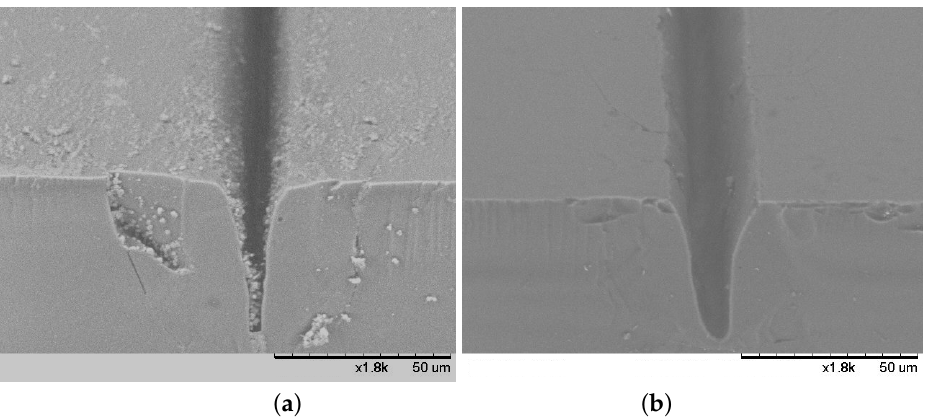
Figure 11. SEM photographs of the grooves formed while the glass sample surface was dry ( a ) and immersed in KOH aqueous solution ( b ).